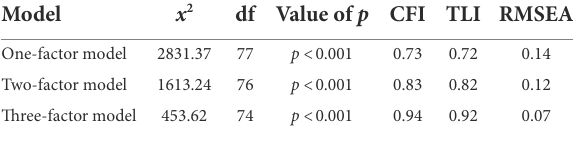
TABLE 1 Results of confirmatory factor